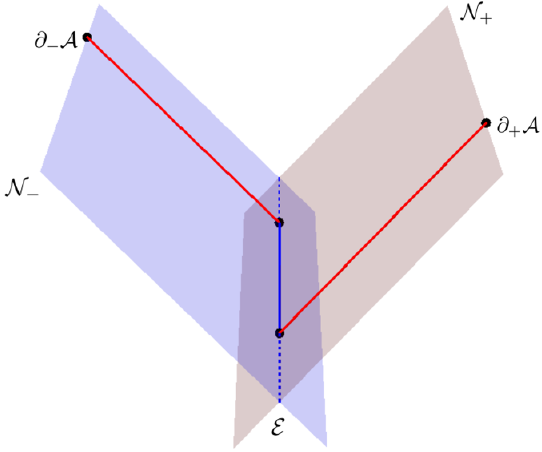
Figure 12 . The two red lines are the null rays (cid:13) (cid:6) emanating from @ (cid:6) A and normal to E . The geodesic E is cut o(cid:11) where it intersect with (cid:13) (cid:6) . The solid blue segment is just our E reg